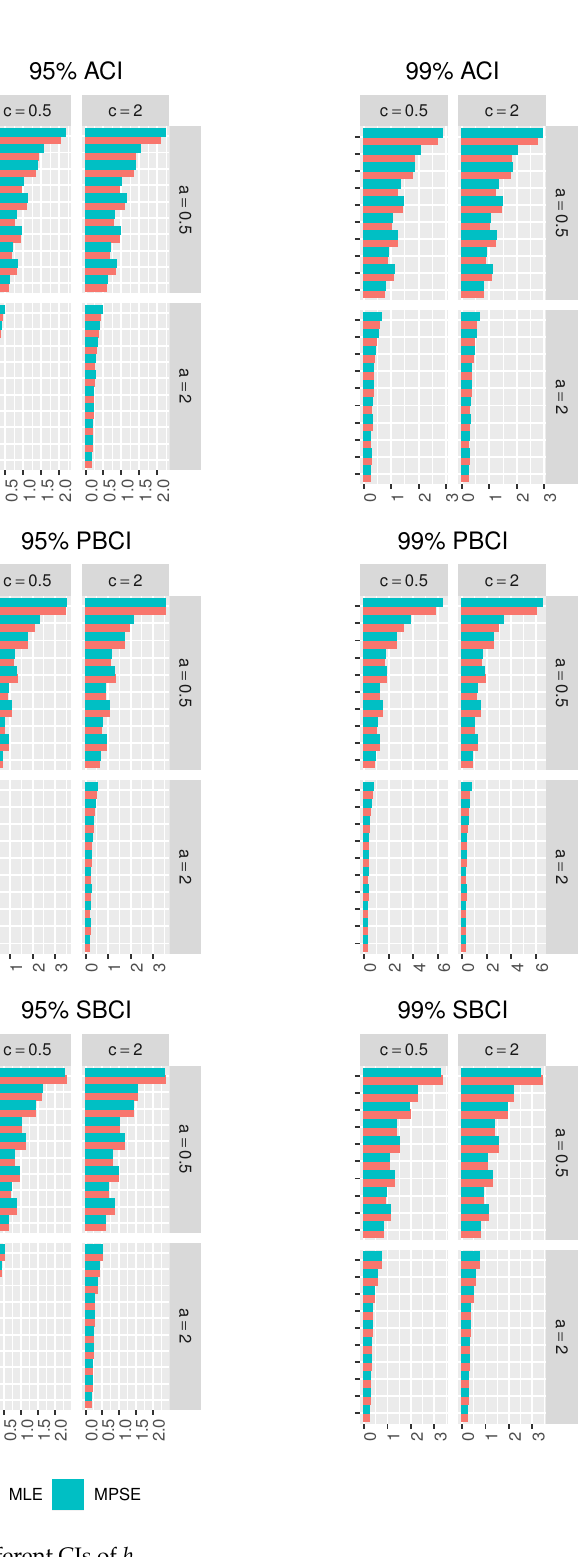
Figure 6. Simulated Lens of different CIs of b